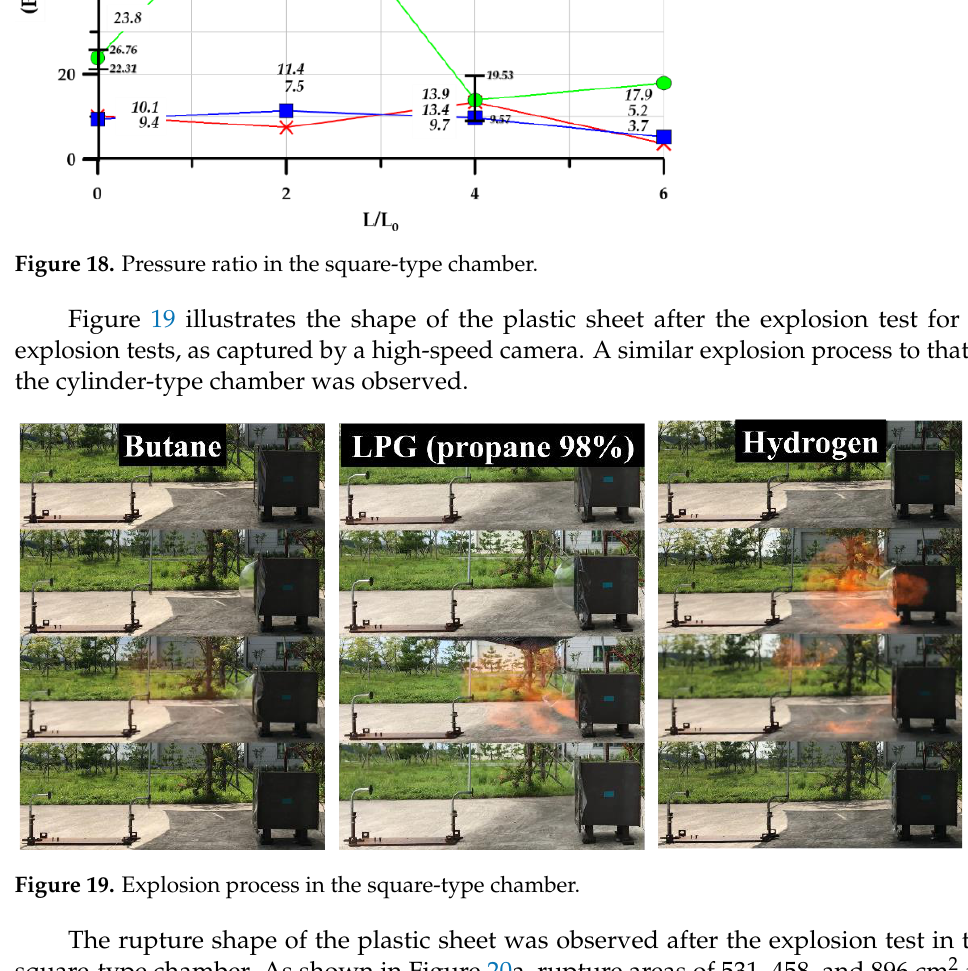
Figure 19. Explosion process in the square-type chamber.